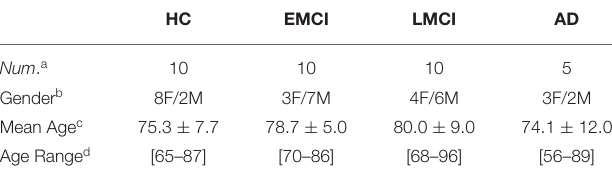
TABLE 1 | The characteristics of the HC, EMCI, LMCI, and